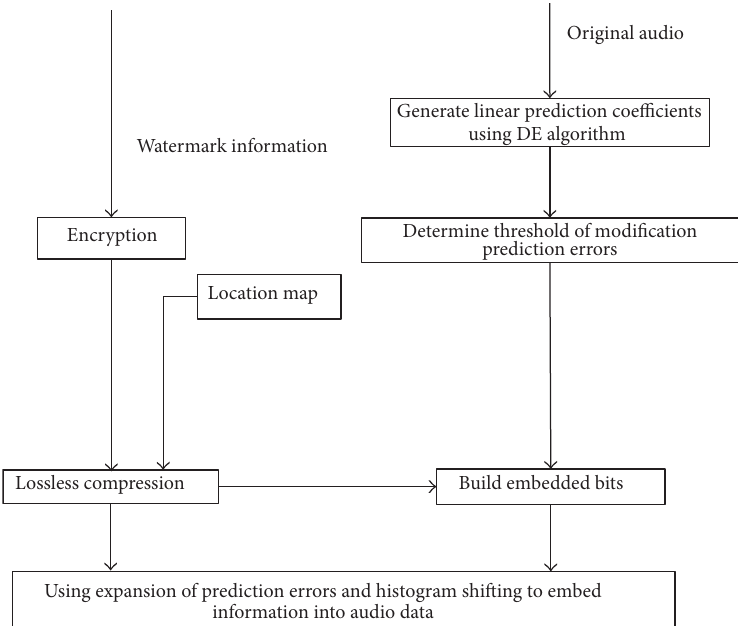
Figure 3: Diagram of watermark embedding